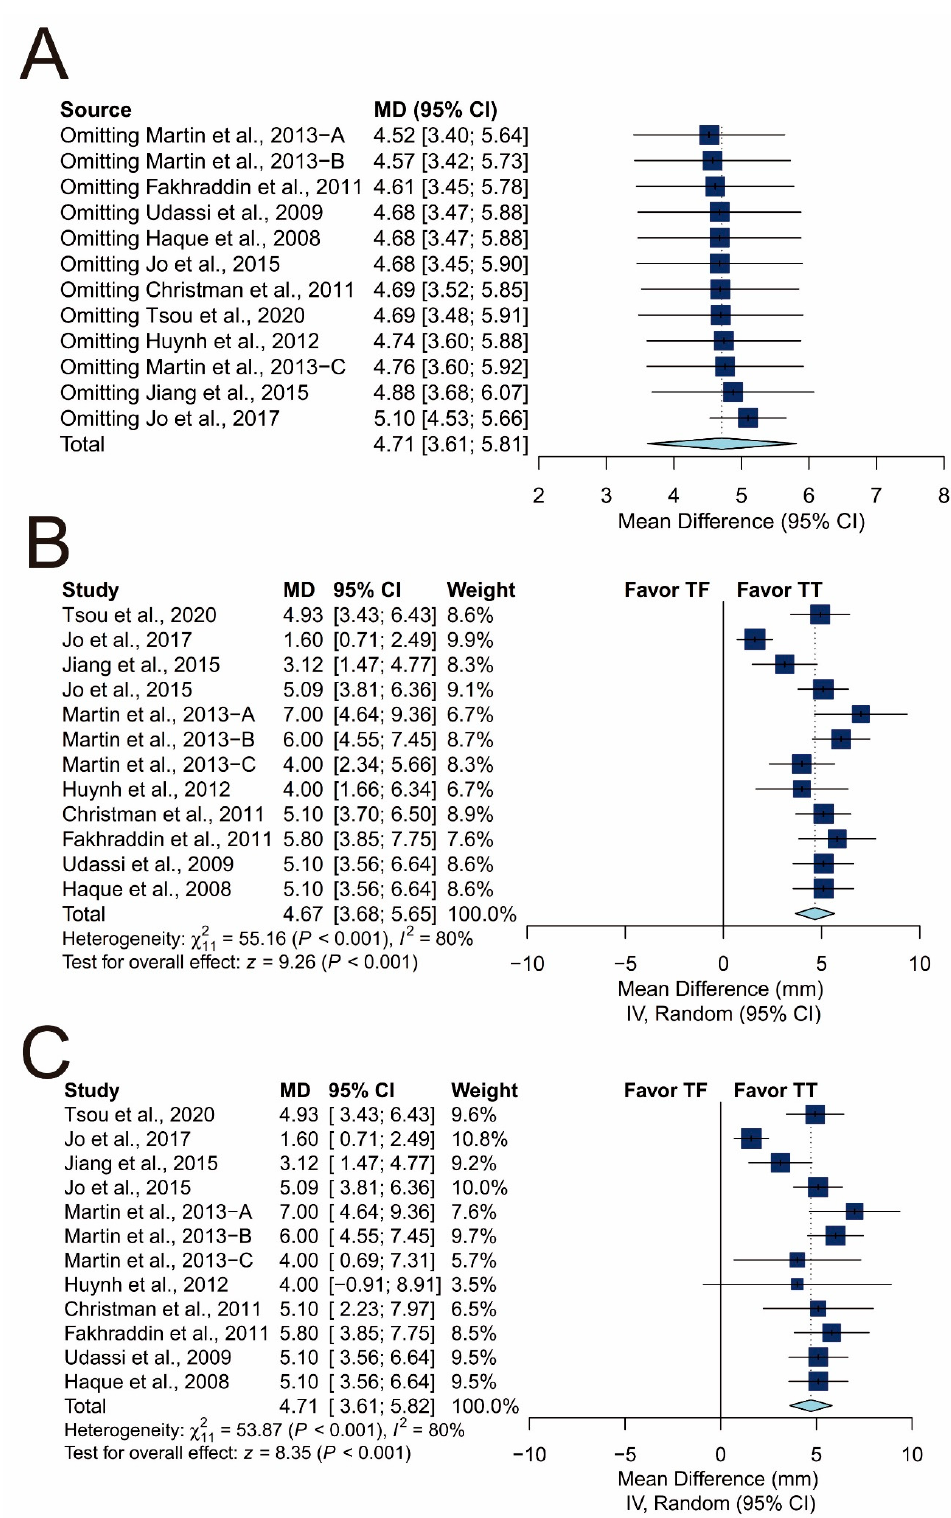
Figure 10. Sensitivity analysis of chest-compression depth. ( A ) Influence analysis; ( B ) forest plot with correlation set as highest observed (0.78); ( C ) forest plot with correlation set as